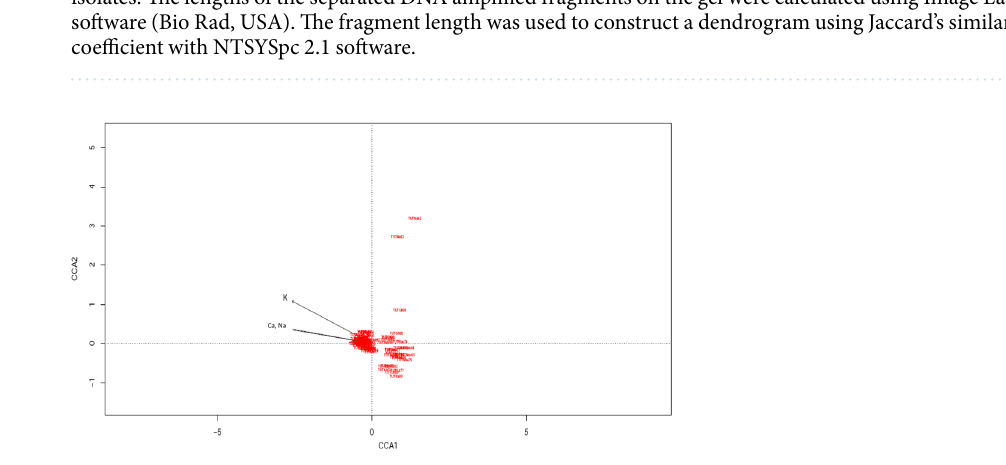
Figure 3. Canonical correspondence analysis (CCA) plot generated using the data from ERIC-PCR banding pattern and soil chemical properties to show the distribution of Bambara groundnut nodulating rhizobia from different locations in Mali, South Africa and